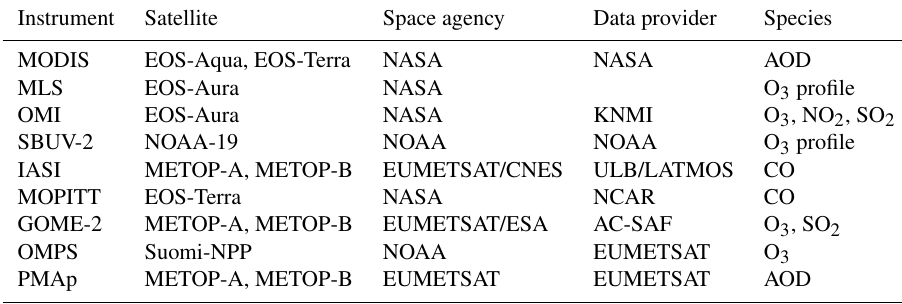
Table 1. Satellite data streams (atmospheric composition variables only) assimilated in IFS. Instrument Satellite Space agency Data provider Species MODIS EOS-Aqua, EOS-Terra NASA NASA AOD MLS EOS-Aura NASA OMI EOS-Aura NASA KNMI O 3 , NO 2 , SO 2 SBUV-2 NOAA-19 NOAA NOAA IASI METOP-A, METOP-B EUMETSAT/CNES ULB/LATMOS MOPITT EOS-Terra NASA GOME-2 METOP-A, METOP-B EUMETSAT/ESA OMPS Suomi-NPP NOAA EUMETSAT METOP-A, METOP-B EUMETSAT EUMETSAT